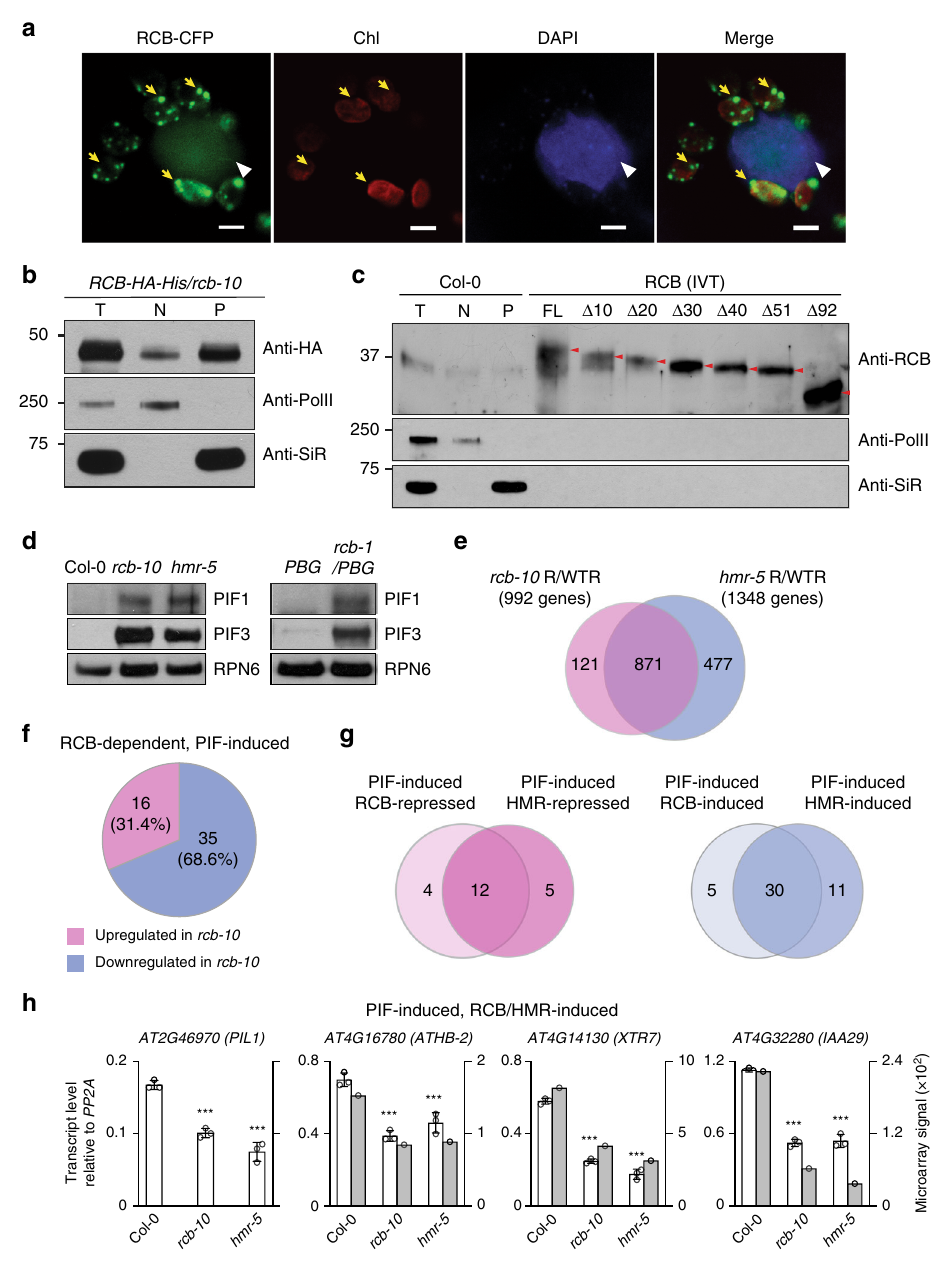
Fig. 4 RCB is a dual-targeted protein that regulates the stability and activity of PIFs. a Confocal images showing that transiently-expressed RCB-CFP localizes to plastids and the nucleus in tobacco cells. Chlorophyll auto fl uorescence (Chl) and DAPI staining were used to label chloroplasts (indicated by yellow arrows) and nuclei (indicated by white arrowheads), respectively. The bars represent 5 μ m. b Immunoblots showing total (T), nuclear (N), and plastidial (P) protein fractions from 4-d-old RCB-HA-His/rcb-10 seedlings grown in 10 μ mol m − 2 s − 1 R light. RCB-HA-His was detected using anti-HA antibodies. c Immunoblots showing endogenous RCB from total (T), nuclear (N), and plastidial (P) protein extracts from 4-d-old Col-0 seedlings grown in 10 μ mol m − 2 s − 1 R light. RCB was detected using anti-RCB antibodies. In vitro translated (IVT) full-length RCB and a series of N-terminal truncation fragments were used as molecular size controls. For ( b ) and ( c ), RNA polymerase II (Pol II) and SiR were used as controls for the nuclear and plastidial fractions, respectively. d Immunoblots showing the levels of PIF1 and PIF3 in 4-d-old indicated lines grown in 10 μ mol m − 2 s − 1 R light. RPN6 was used as a loading control. e Venn diagram showing that 871 of the 992 RCB-dependent genes overlap with the previously de fi ned HMR-dependent genes. f Venn diagram showing that the majority of RCB-dependent, PIF-induced genes were downregulated in rcb-10 . g Venn diagrams showing that RCB regulates similar PIF-regulated genes as HMR. h Microarray and qRT-PCR analyses of the mRNA levels of selected PIF-induced, RCB/HMR-induced genes in 4-d-old Col-0, rcb-10 , and hmr-5 seedlings grown in 10 μ mol m − 2 s − 1 R light. The fi lled and open columns represent data from microarray and qRT-PCR, respectively. Transcript levels from the qRT-PCR experiments were calculated relative to those of PP2A . Error bars represent SD of three biological replicates. *** Indicates statistically signi fi cant differences in the transcript level from that of Col-0 (Student ’ s t -test, p ≤ 0.001). The source data underlying the immunoblots in ( b – d ) and the qRT-PCR analysis in ( h ) are provided in the Source Data fi